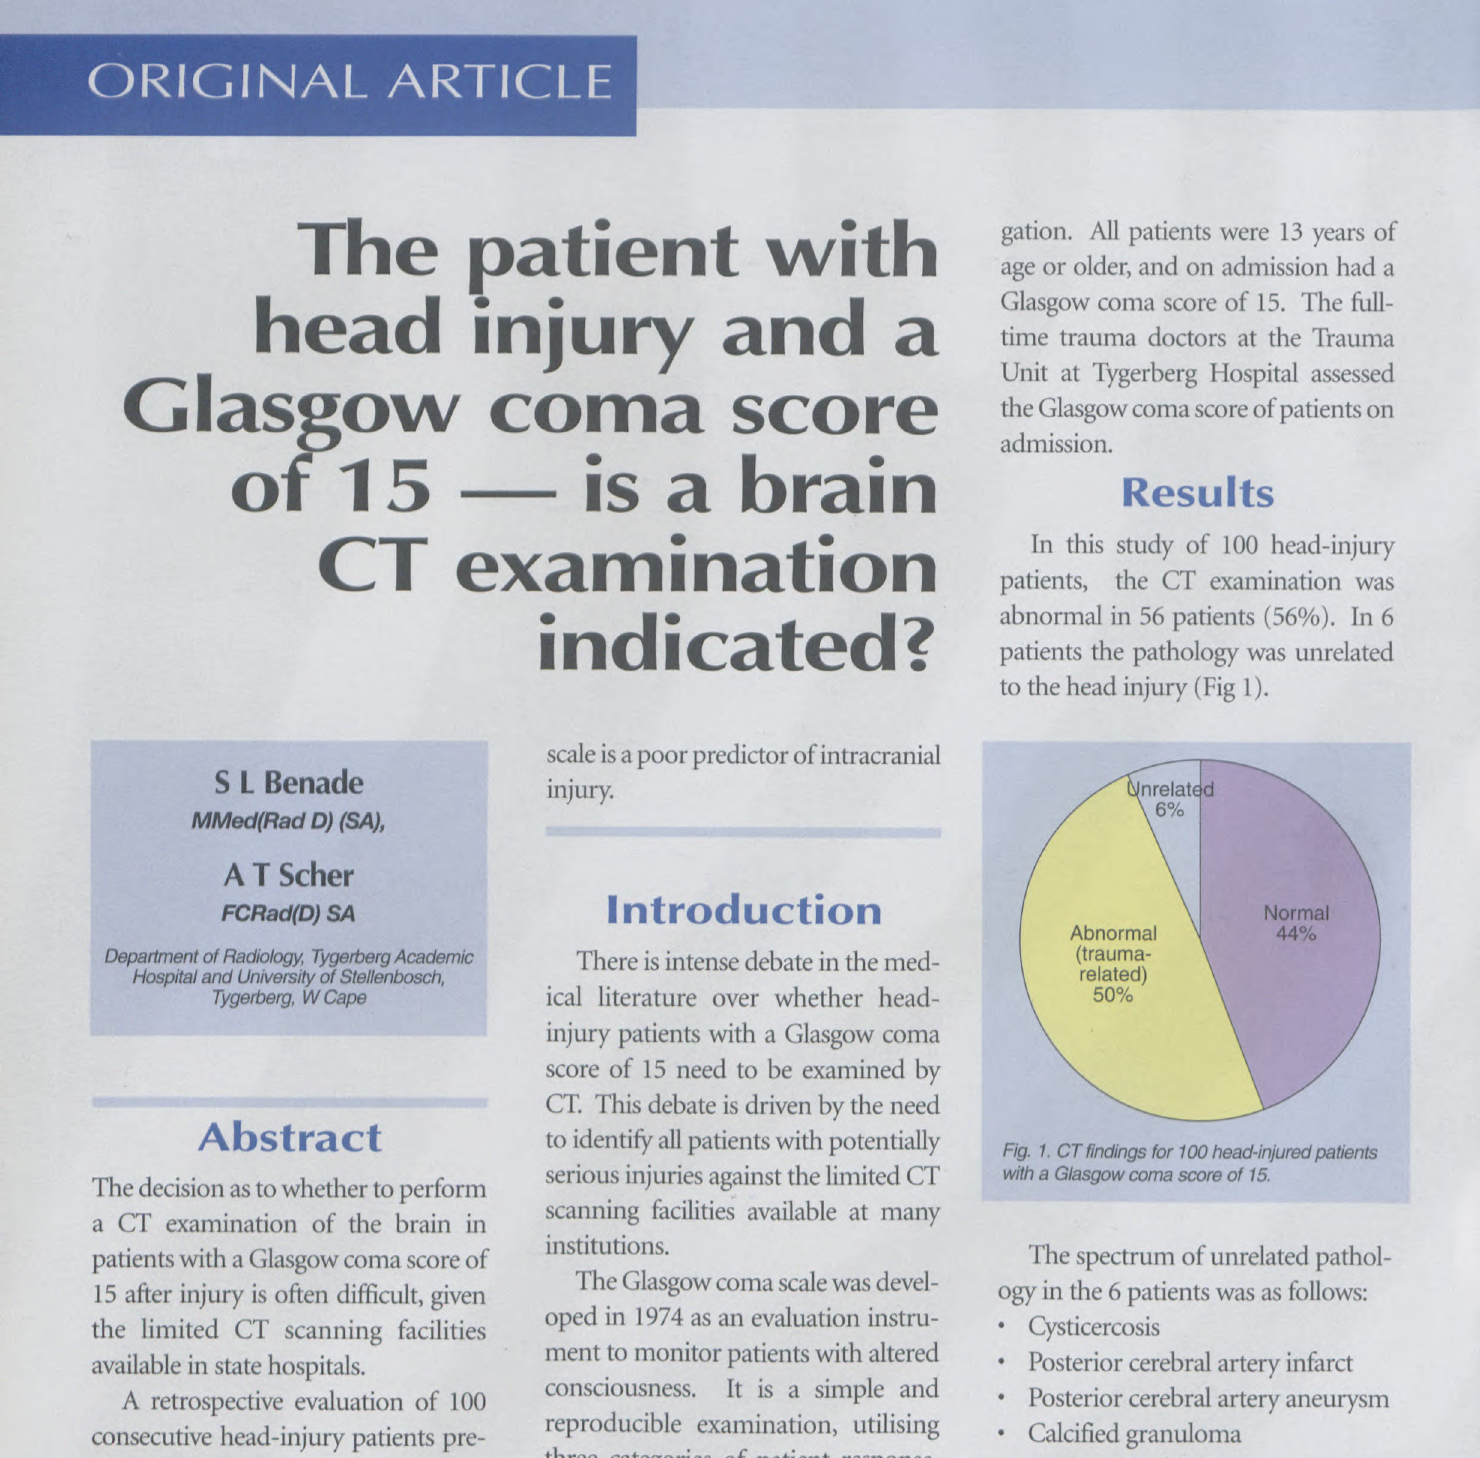
Fig. 1. CTfindings for 100 head-injured patients with a Glasgow coma score of